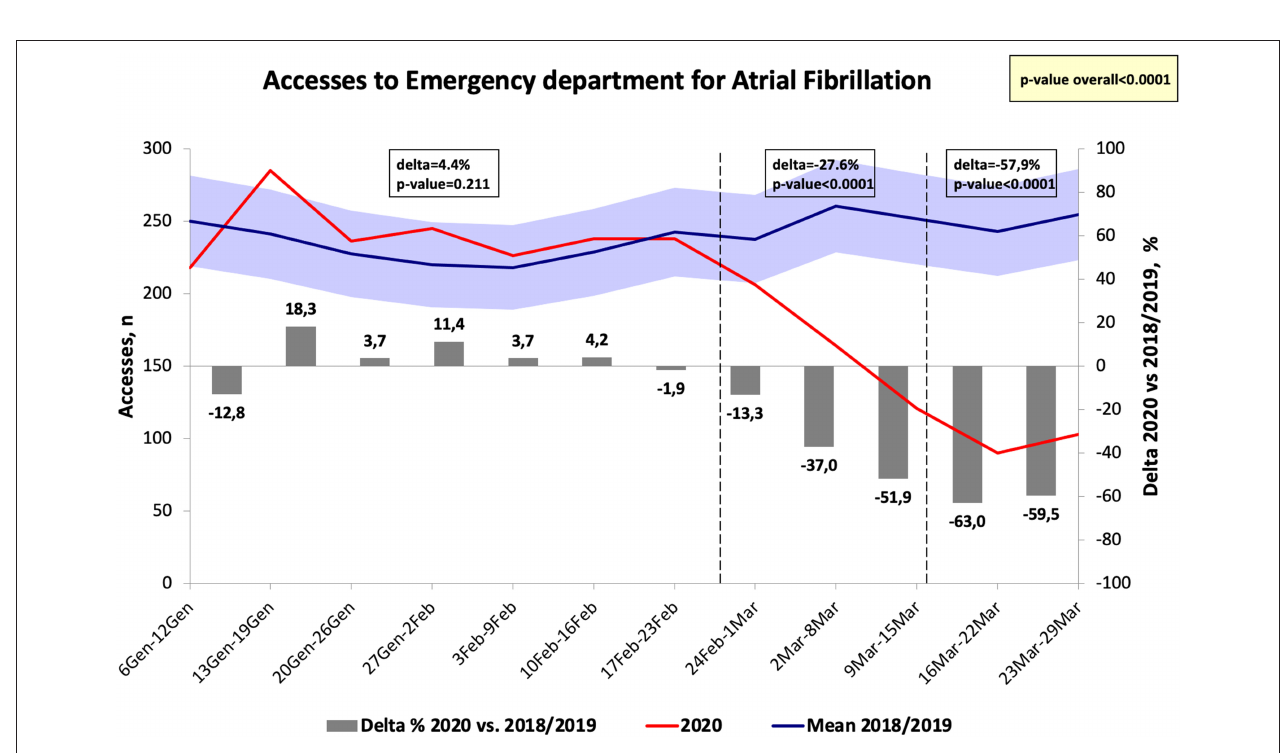
FIGURE 5 | Number of accesses to emergency department for atrial fibrillation in Tuscany.